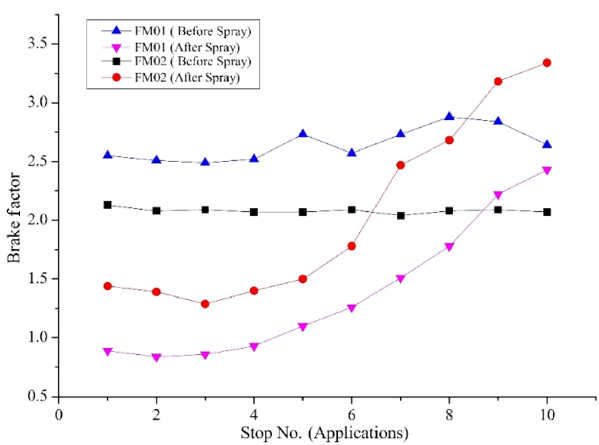
Fig. 8 Brake jamming test performance of the developed composites.